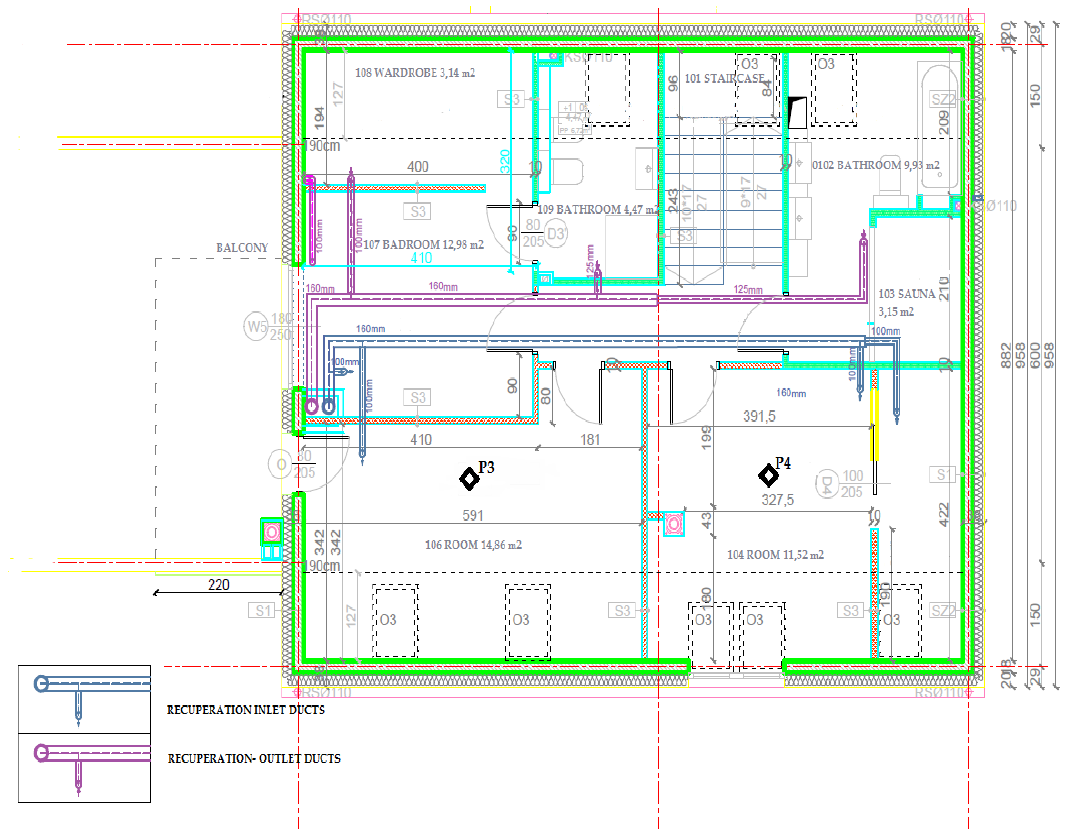
Figure 5. The view of the ground floor of the building with marked measuring points P3 and P4 (black dots) and the layout of the ventilation system with the distinction of inlet and outlet points.